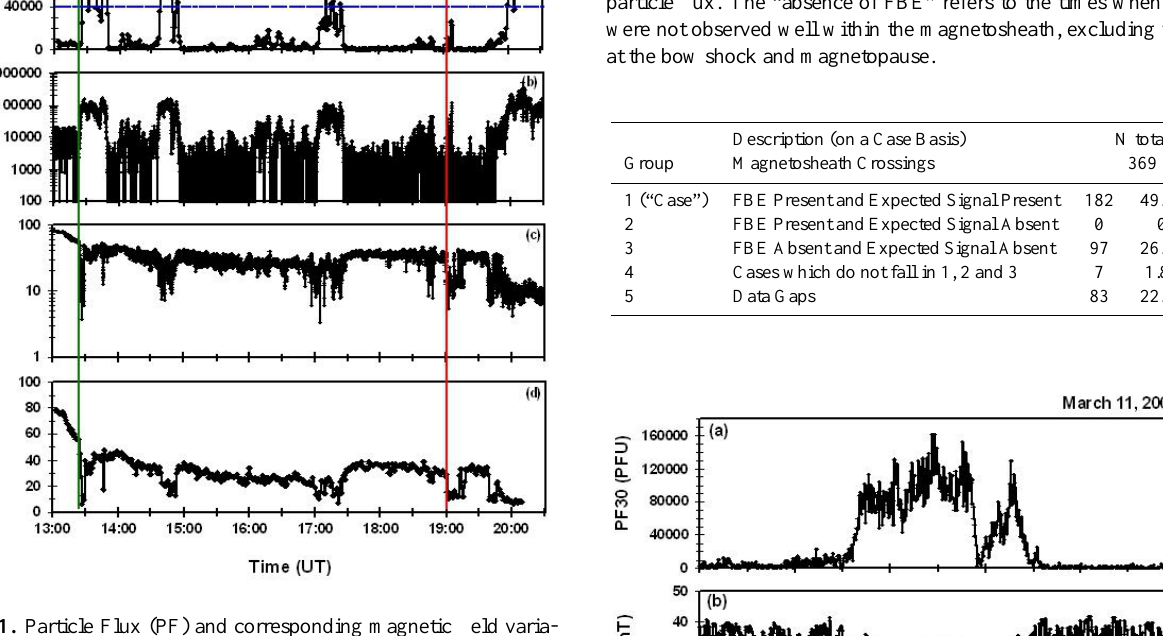
Fig. 1. Particle Flux (PF) and corresponding magnetic field varia- tions in the magnetosheath for 11 March 2002 at different time res- olutions. The panels give (a) 1min PF30 (particle flux for particles with energies ≥ 30keV), (b) 4s PF30 in logarithmic scale, (c) 4s magnetosheath magnetic field in logarithmic scale, and (d) 1min magnetosheath magnetic field. Particle flux unit PFU stands for the Particle Flux Unit in #/cm 2 sstr. Red and green lines show the bow shock and the magnetopause boundaries as Cluster travels the magnetosheath from the magnetosphere into the solar wind. The dashed blue line is the flux threshold level used in selecting flux burst events.